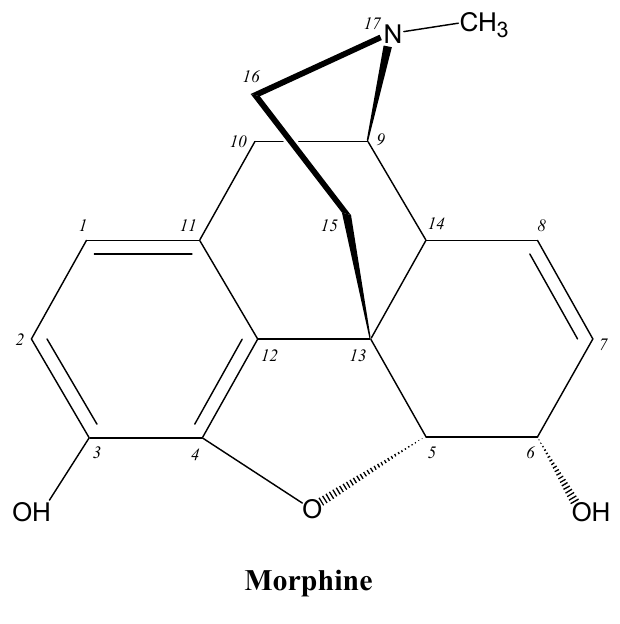
Figure 21. Structure of the opioid analgesic drug